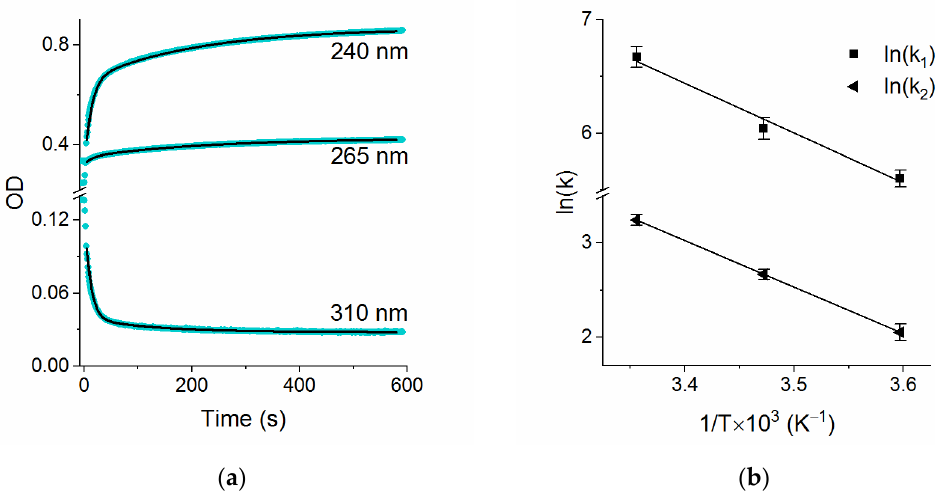
Figure 2. ( a ) Experimental (blue points) and theoretical (black lines) kinetic curves recorded during OSSO reduction at T = 15 °C and GSH = 0.3 mM; ( b ) Arrhenius plots for k 1 and k 2 rate constants with the linear fit. The same measurements were performed for two other temperatures, 15 °C and 5 °C. Table 1. Rate constants of the reactions of OSSO reduction and OSH